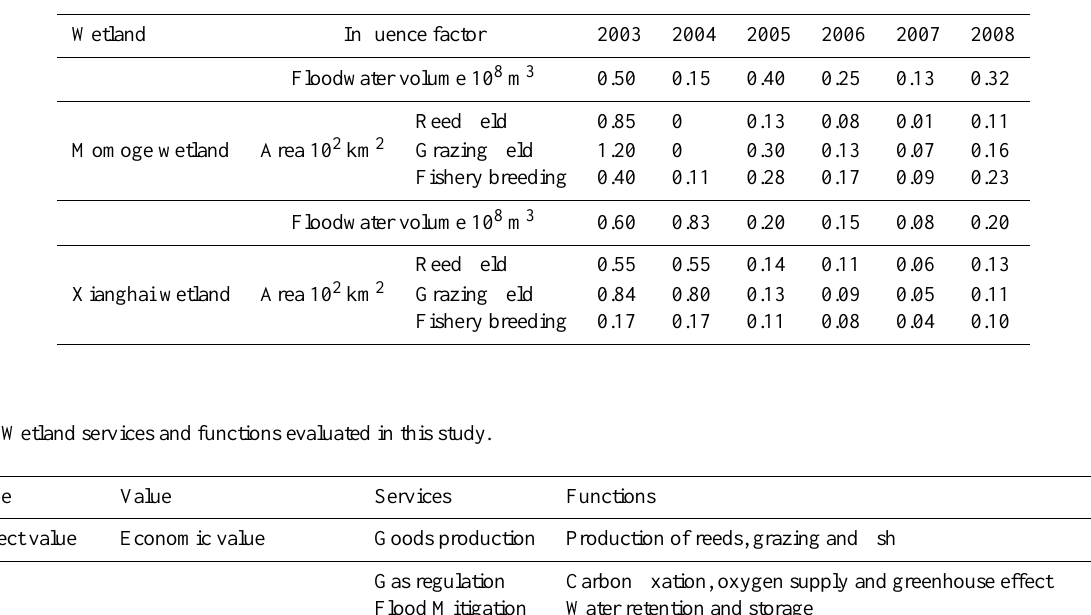
Table 1. Floodwater utilisation volume and wetlands area from 2003 to 2008.